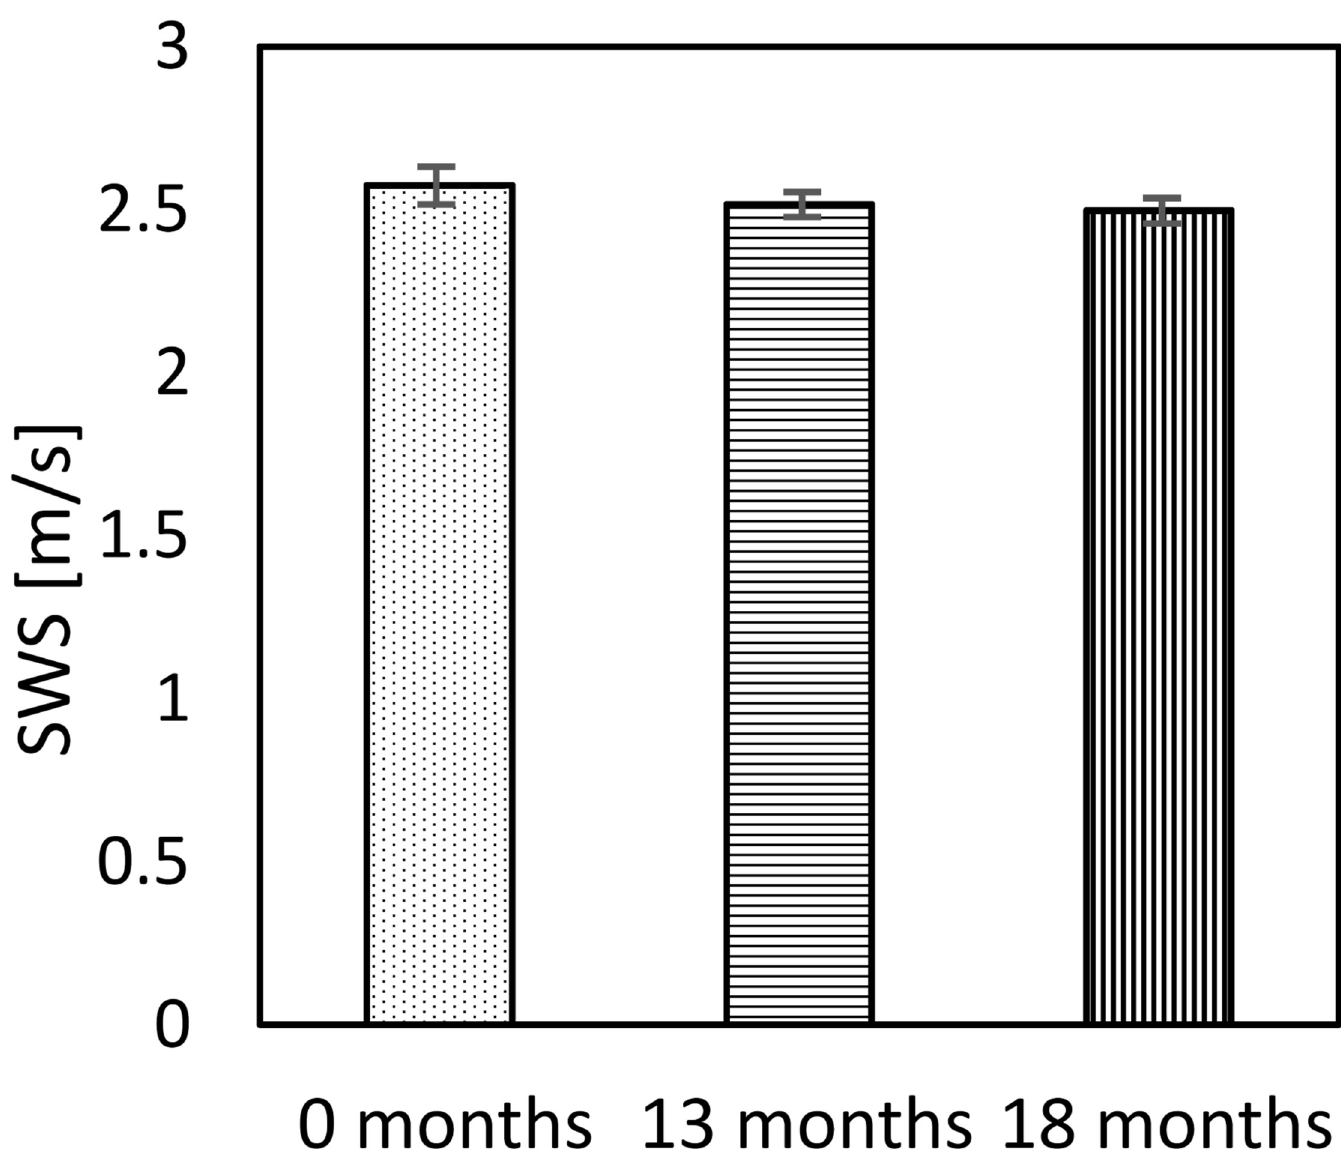
Fig 4. Longitudinal change of SWS obtained from US SWE. The error bars represent the SD of 15 SWS (5 ROIs x 3 times) estimates. A Kruskal-Wallis test found a significant difference between the SWS at each time point (p = 0.00).